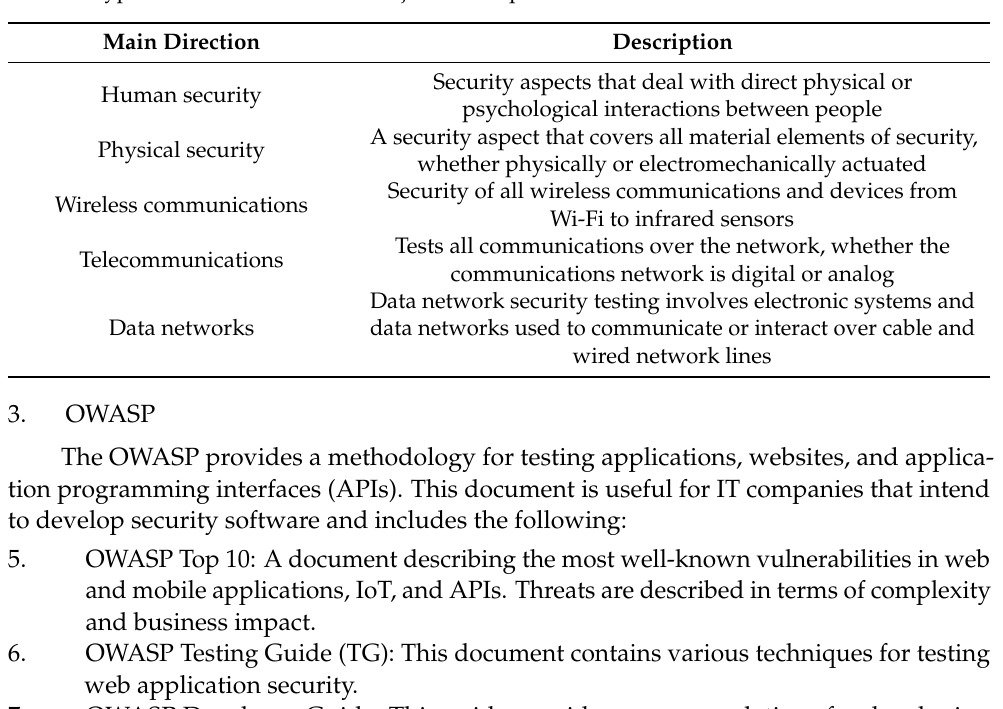
Table 8. Types and characteristics of major control